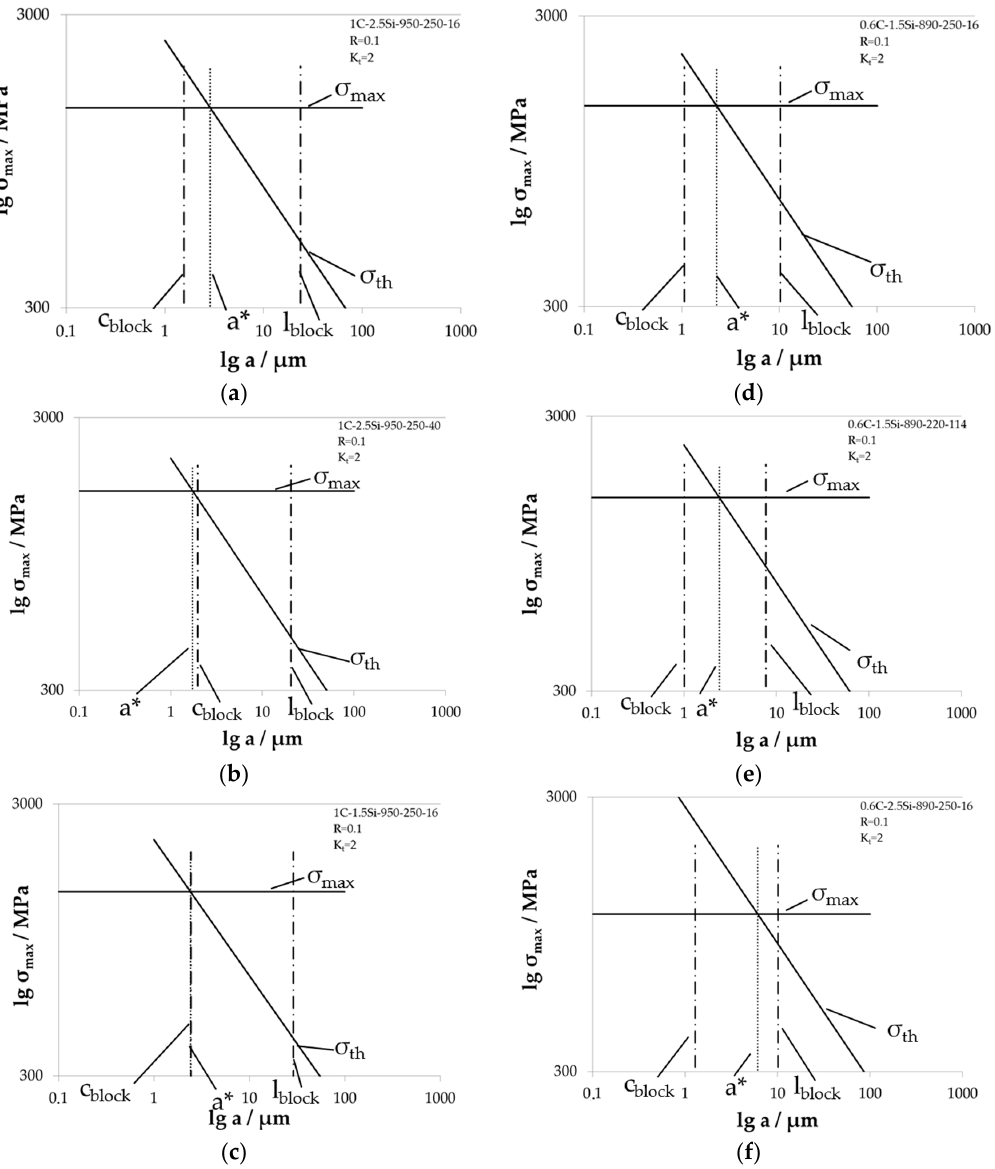
Figure 14. Individual Kitagawa diagrams for material states tested with load ratio R = 0.1 at specimens with notch factor K t = 2 for ( a ) 1C-2.5Si-950-250-16; ( b ) 1C-2.5Si-950-250-40; ( c ) 1C-1.5Si-950-250-16; ( d ) 0.6C-1.5Si-890-250-16; ( e ) 0.6C-1.5Si-890-220-114; and ( f ) 0.6C-2.5Si-890-250-16.